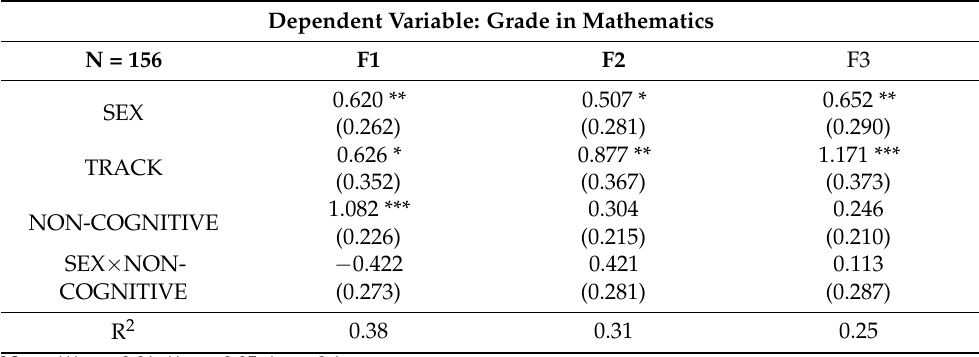
Table 8. Coefficients of linear models explaining grades. PCA factor as explanatory variables. Dependent Variable: Grade in